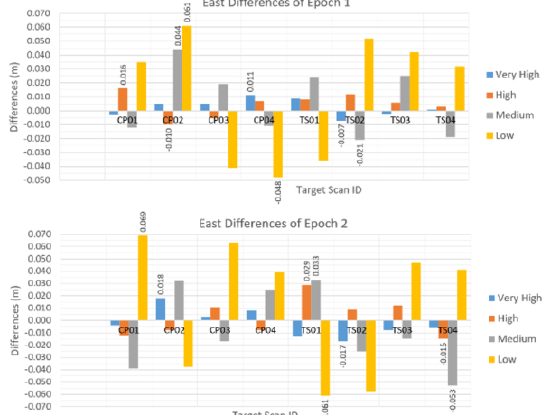
Figure 45. Easting coordinates differences between manually point picking and automatically computed by ScanMaster software (epoch 1 and 2)